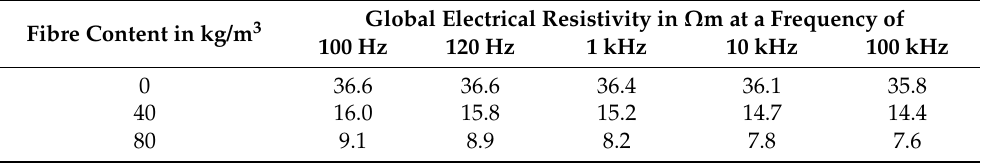
Table A47. Results of the resistivity measurements of the concrete mixture 32-60-300-00 after storage in synthetical pore solution for 7 days for the investigations of possible leaching effects.